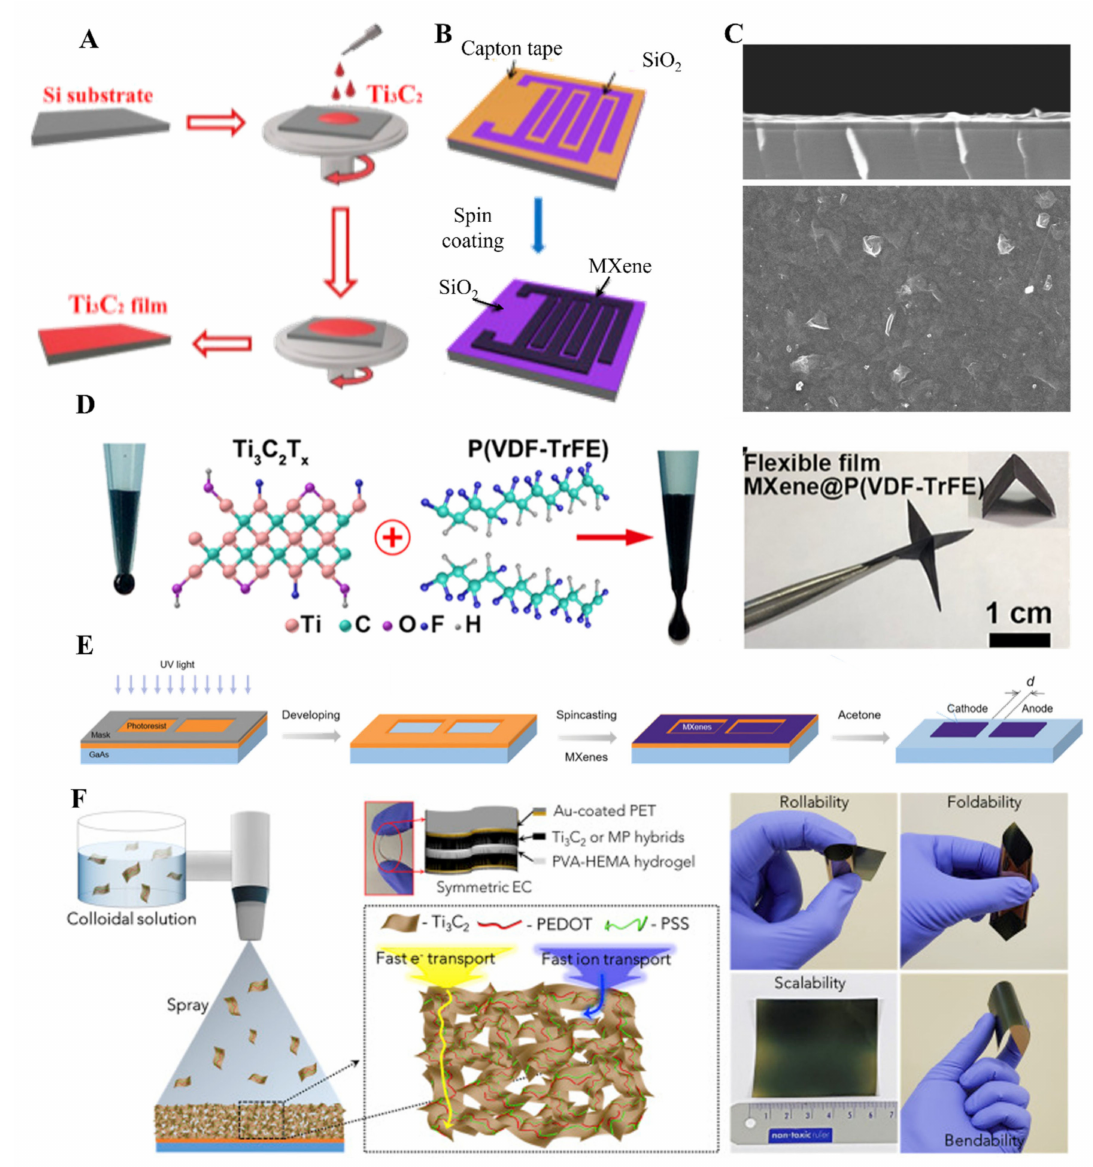
Figure 5. ( A ) Schematic drawing of SCM (reproduced with permission [78]. Copyright 2019, Elsevier); ( B ) Schematics of Ti 3 C 2 T x MXene film formation on patterned silicon substrate using SCM method, (reproduced with permission [79]. Copyright 2020, Elsevier); ( C ) SEM images of Ti 3 C 2 T x MXene film formed by SCM. The scale bar is 5 µ m (reproduced with permission [80]. Copyright 2019, Wiley- VCH); ( D ) Fabrication of Ti 3 C 2 T x MXene film on a flexible substrate with SCM (reproduced with permission [85]. Copyright 2020, American Chemical Society); ( E ) Photolithography was performed for patterning, and SCM was utilized for the fabrication of MXene film on the designed surface (reproduced with permission [86]. Copyright 2019, Wiley-VCH); ( F ) Schematic of MXene@PEDOT: PSS thin films fabricated using SCM and symmetric capacitors, photographic images of composite MXene thin films their scalability, foldability, and rollability (reproduced with permission [83]. Copyright 2018,